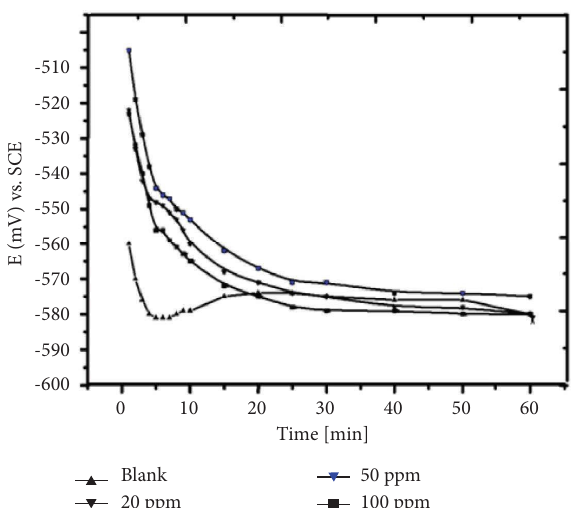
Figure 12: Variation of the open-circuit potential of mild steel with time in a stagnant naturally aerated aqueous solution of 1M H diferent concentrations of PSA at 25 °